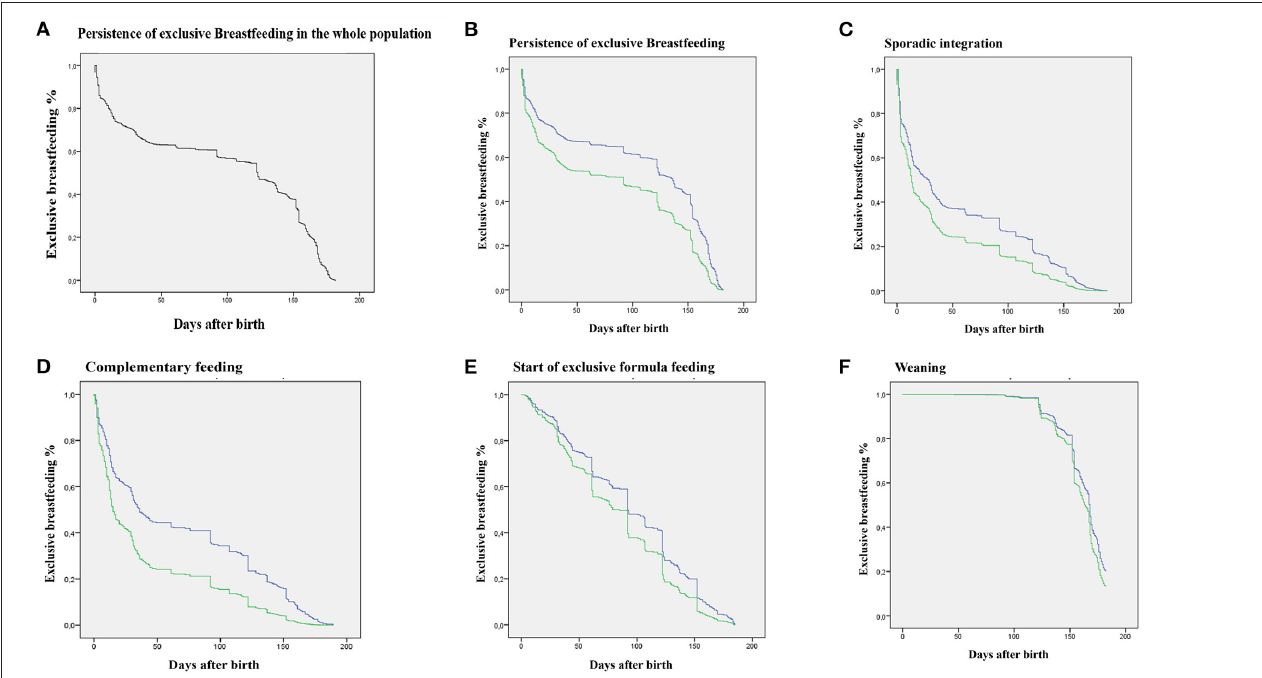
FIGURE 2 | Survival curves obtained by Cox regression. Green: WL ≥ 7% group; blue: WL < 7%. (A) Decay over time (days) of exclusive breastfeeding in the entire population. (B) Decay over time (days) of exclusive breastfeeding differentiated for the two groups. (C) Decay over time (days) of exclusive breastfeeding in relation to the occurrence of the event Sporadic Integration. (D) Decay over time (days) of exclusive breastfeeding in relation to the occurrence of the event Start of Complementary Feeding. (E) Decay over time (days) of exclusive breastfeeding in relation to the occurrence of the event Start of Exclusive Formula Feeding. (F) Decay over time (days) of exclusive breastfeeding in relation to the occurrence of the event Weaning. All curves, except the Weaning curve, significantly differ ( p <